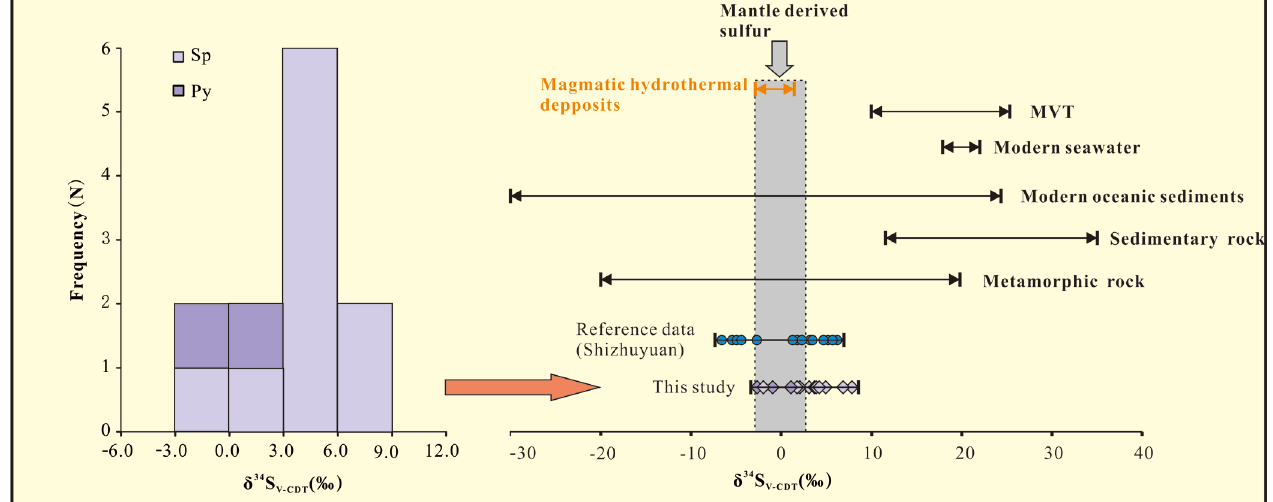
Figure 12. Comparison of sulfur isotope compositions of Hongqiling Sn-W polymetallic deposit and Shizhuyuan W-Sn polymetallic deposit with mantle-derived sulfur in the same period (isotopic data range from [63]).